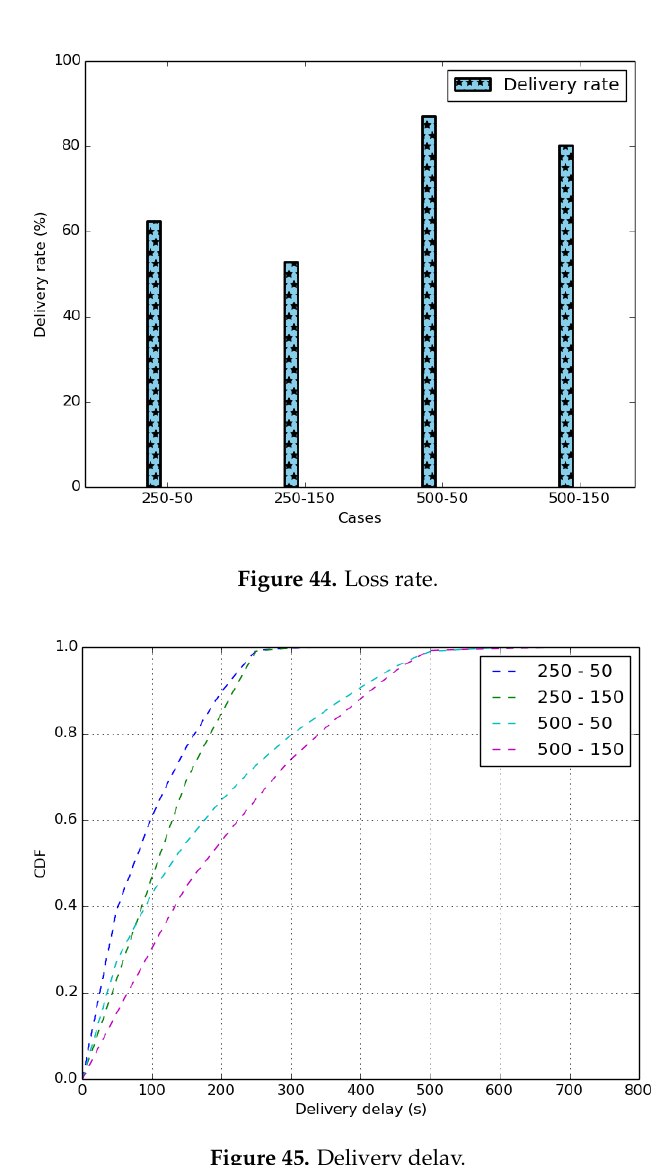
Figure 45. Delivery